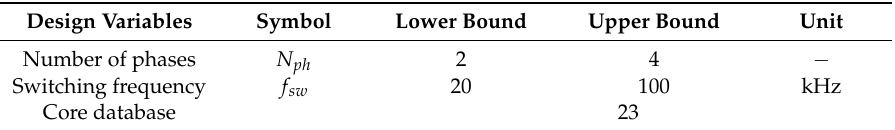
Table 2. Design variable bounds.